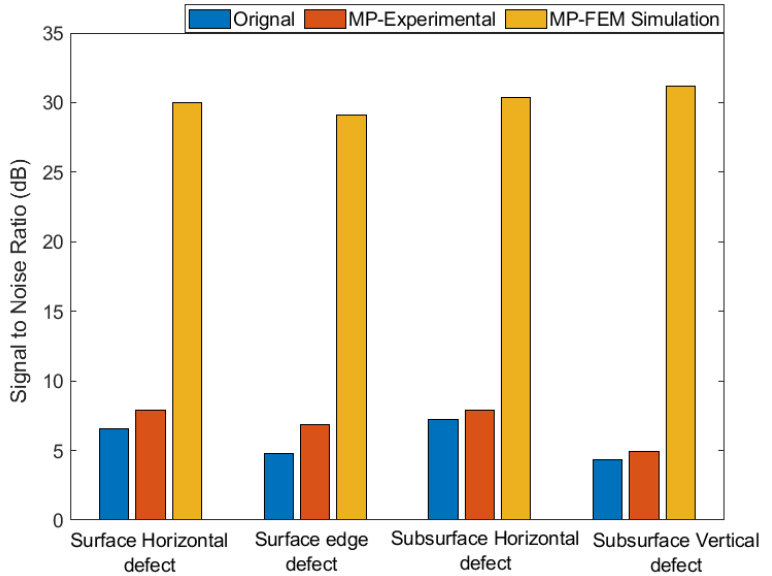
Figure 14. Comparison of SNR values of the original signals and reconstructed signals after MP with the experimental and FEM simulation dictionaries for specimen B with surface horizontal defect, specimen C with surface edge defect, specimen D with subsurface horizontal defect and specimen E with subsurface vertical defect. Table 3. Comparison of MP with FEM simulation and experimental dictionaries to locate railhead surface and subsurface